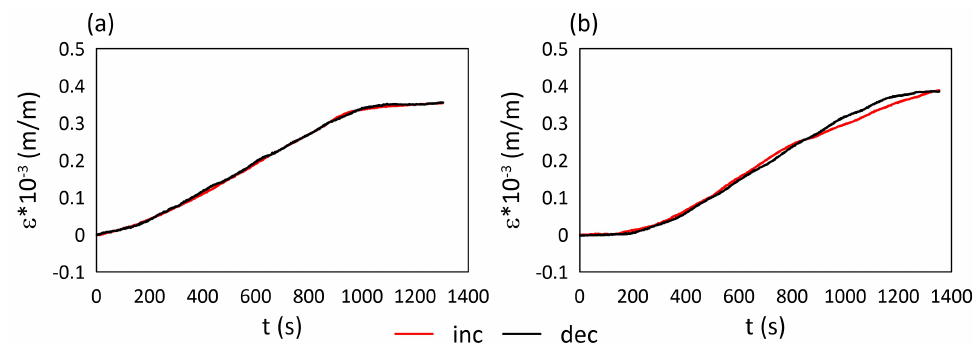
Figure 4. Strain hysteresis: ( a ) M3 X, ( b ) M3 Crystal; inc—temperature increasing, dec—temperature